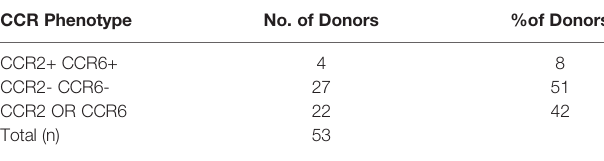
TABLE 3 | Patterns of co-expression of chemokine receptors from blood donors.